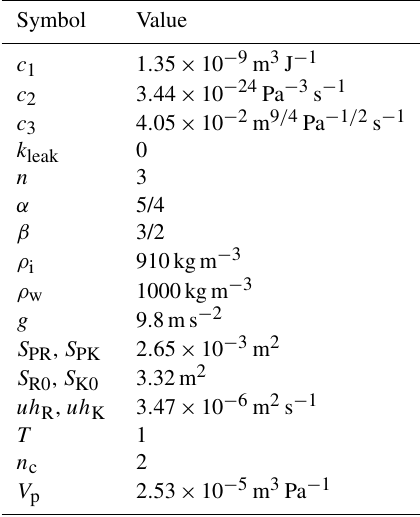
Table 1. Parameters used in the